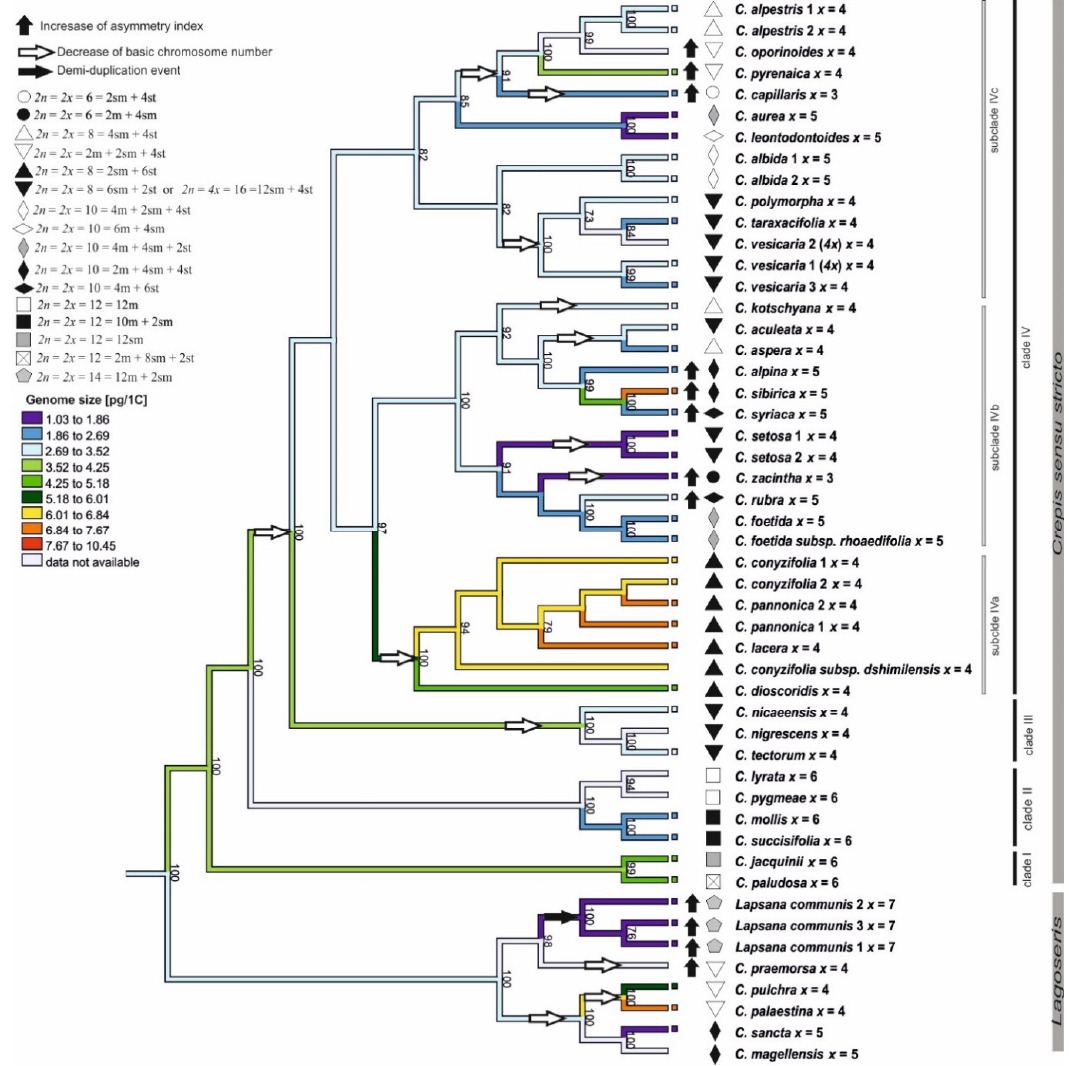
Figure 5. Karyotype evolution in the analysed species of Crepis s.l. Genome sizes were mapped on the ML tree of concatenated cpDNA sequences using the maximum likelihood method implemented in Phytools. Karyotype formulas (symbols preceding the species names) and the increases in karyotype asymmetry (black arrows) are indicated for all species. The genome sizes, karyotype formulas, and asymmetry indexes of each species are presented in Table 2. The figure includes only species for which all three datatypes (chromosome number, karyotype formula, and asymmetry index) were provided. The tree was rooted with Picris hieracioides, Lactuca serriola , and Sonchus oleraceus.